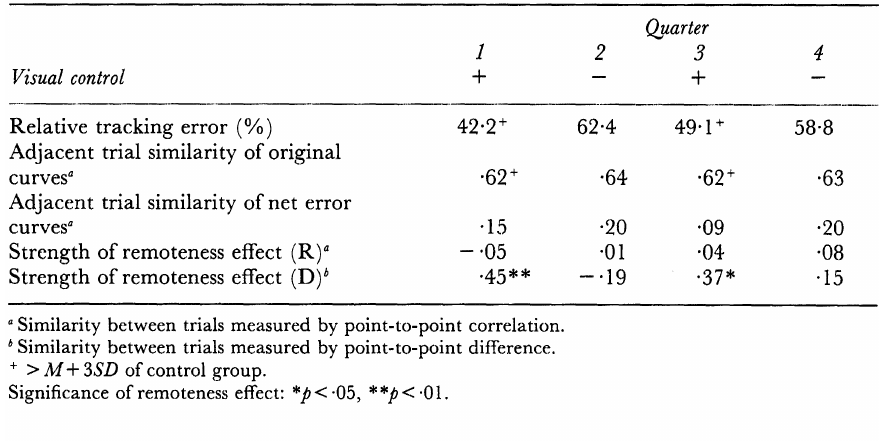
, Similarity between trials measured by point-to-point correlation_ 'Similarity between trials measured by point-to-point diHerence_